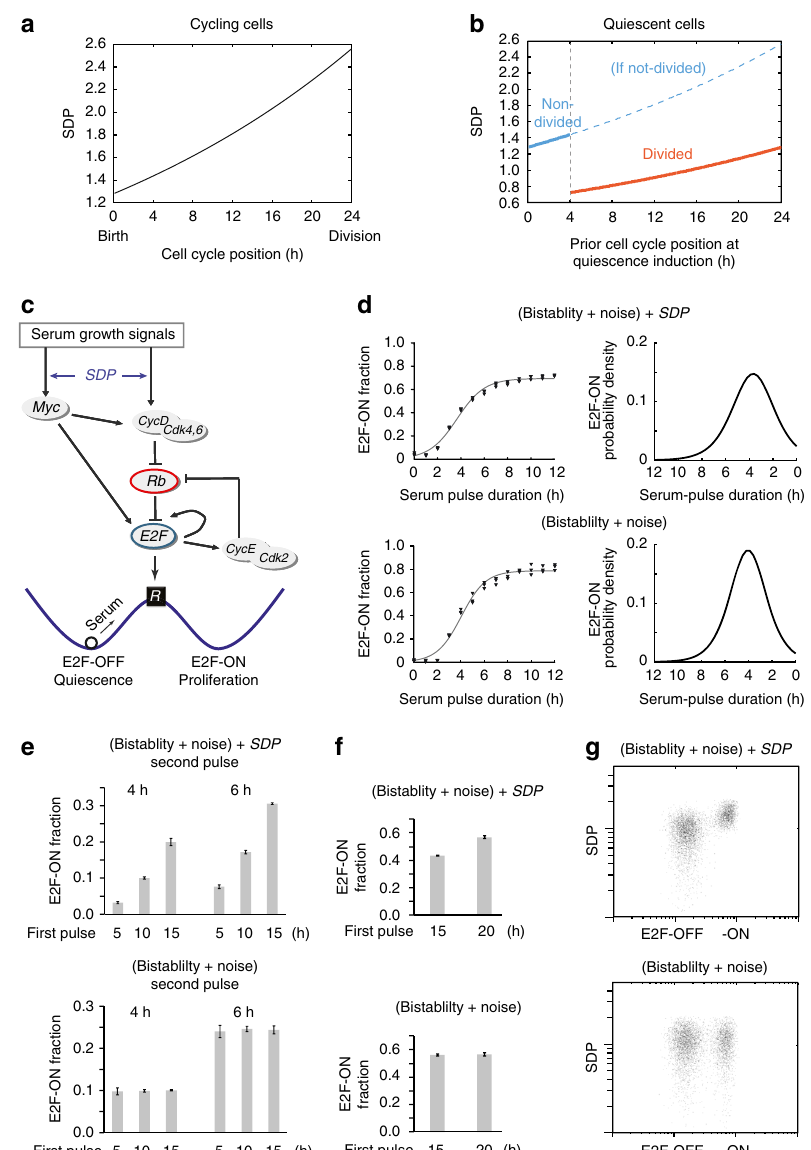
Fig. 4 Model the memory effects of preceding cell growth and division on quiescence exit. a SDP accumulation in a cycling cell from cell birth to division, during which SDP value doubles. Cell cycle position refers to the hours after cell birth, in the presence of serum. b SDP distribution in a population of quiescent cells, related to preceding cell cycle positions at quiescence induction. Cells past the R-point (4h after cell birth) enter quiescence after division with SDP reduced by half. c Rb-E2F bistable network that mediates the all-or-none transition from quiescence-to-proliferation. See text for details. d – g Simulation results based on the stochastic SDP -Rb-E2F model ( top ) vs. stochastic Rb-E2F model without SDP ( bottom ). d ( left ) Each data point represents the E2F-ON fraction calculated from 1000 simulations. Sigmoid curve indicates a best fi t of triplicate data points (with the function form as in Fig. 1b). ( right ) Quiescence-exit distribution as the derivative of the sigmoidal curve on the left. e , f Each column represents the E2F-ON fraction (mean ± s.e.m.) calculated from three sets of stochastic simulations (500 runs each). Cells were simulated according to experimental schemes in Fig. 2a, e (with batch-variation factor S c = 0.55 and 1.15 for the second pulse, respectively). g Results from 5000 simulated cells are shown according to experimental procedure in Fig. 1d ( pd = 3.5h). Each dot represents one stochastic simulation of a single cell. Each cell was randomly assigned a SDP value (in log-normal distribution, y axis), with or without ( top and bottom , respectively) coupling to serum response elements in the Rb-E2F bistable model. The x axis indicates the simulated E2F molecule number at the 24th model hour after serum pulse initiation (plus auto fl uorescence assumed in log-normal distribution, mean =